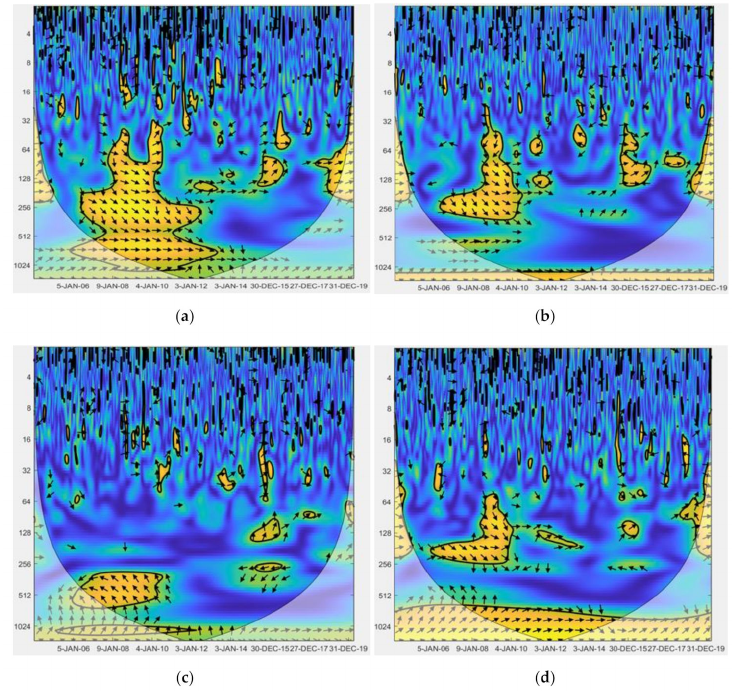
Figure A1. The co-movement between WTI crude oil and stock markets in time-frequency space. ( a ) The US stock market, SP500; ( b ) the Japanese stock market, N225; ( c ) mainland China’s stock market, SSEC; ( d ) Hong Kong’s stock market, HSI.